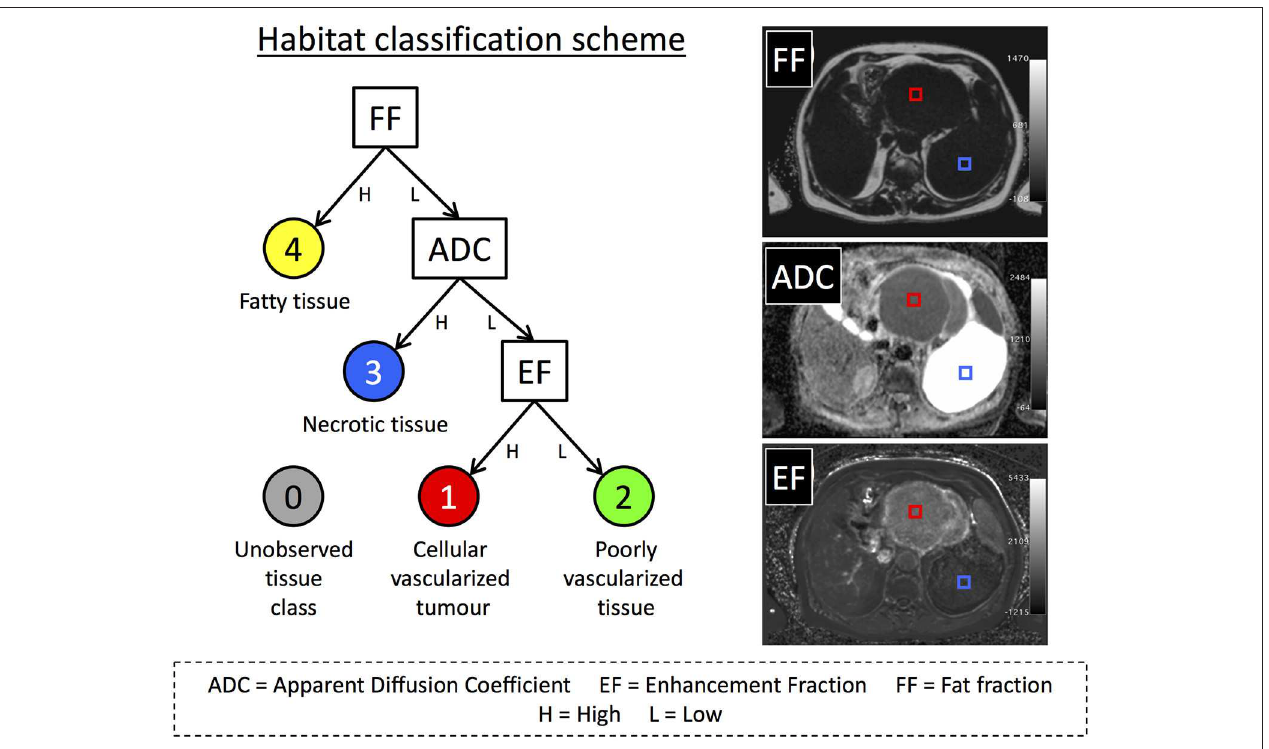
FIGURE 1 | (Left) An illustration of our decision tree used to define habitats within our sarcoma population. Classes 3 and 4 were not further divided as cystic/necrotic regions and fat do not enhance in post-Gd images. ADC is not evaluable in fat- suppressed DWI. (Right) Images from one patient with a dedifferentiated liposarcoma showing examples of training ROIs positioned in regions corresponding to habitat 1 (red) and habitat 3 (blue). Training ROIs (2 cm 2 ) were drawn on either the fat fraction (FF), apparent diffusion-coefficient (ADC), or enhancing fraction (EF) maps, and then transposed onto other maps.